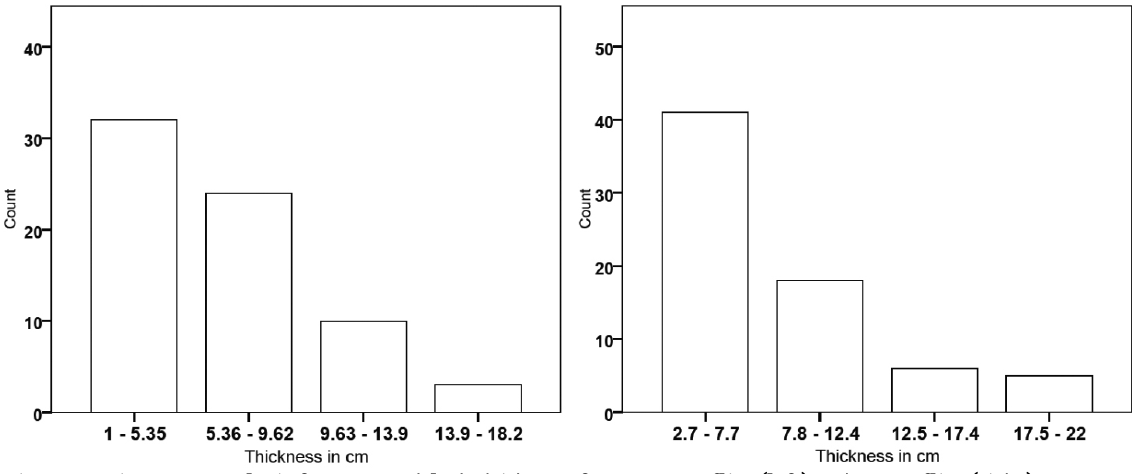
Figure 2. Histogram analysis for average blank thickness for Bergerac flint (left) and SMM flint